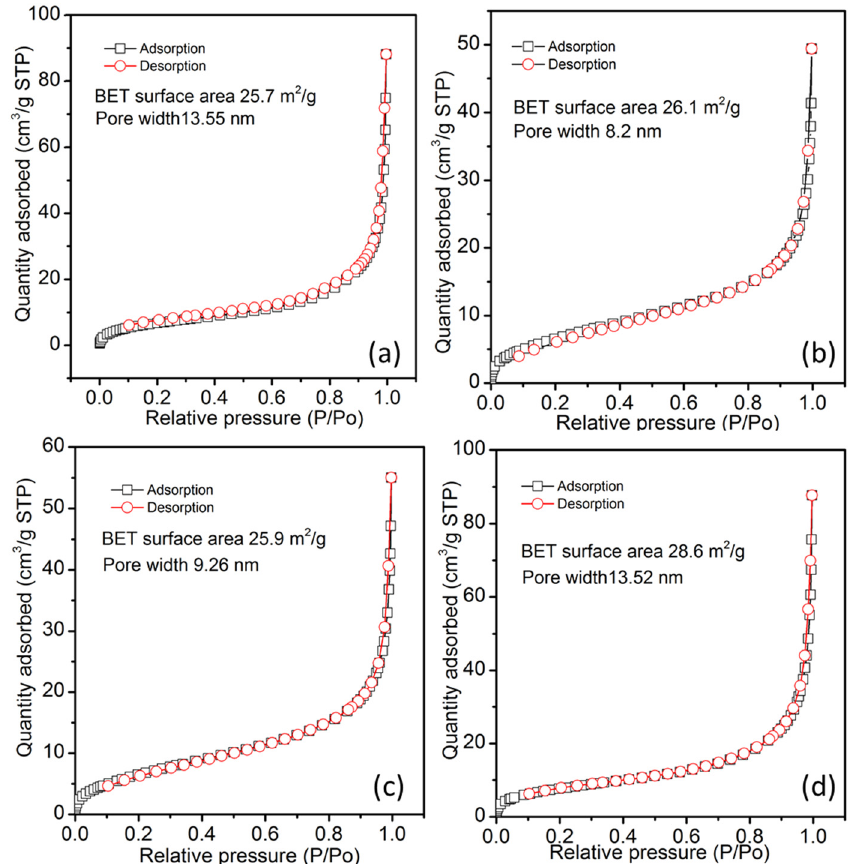
Figure 4: N 2 adsorption – desorption isotherms of M/Fe - MOF ( M = Co, Cu, and Mg ) : ( a ) Fe - MOF, ( b ) Co/Fe - MOF, ( c ) Cu/Fe - MOF, and ( d ) Mg/Fe -